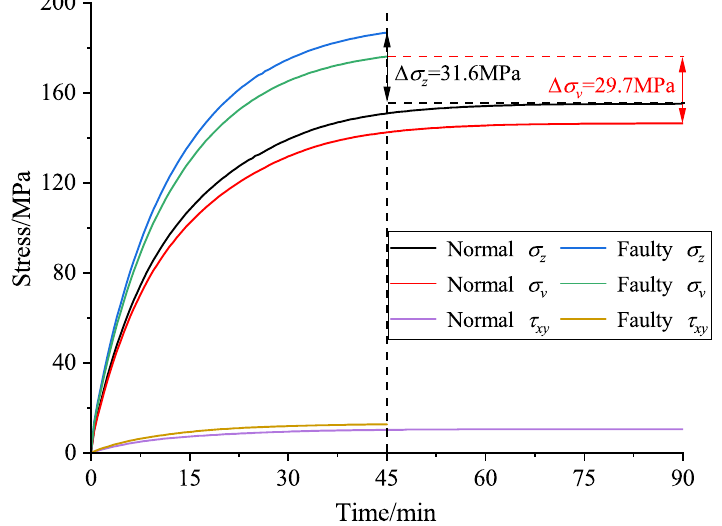
Figure 15. Stress variation curve with time at the maximum stress